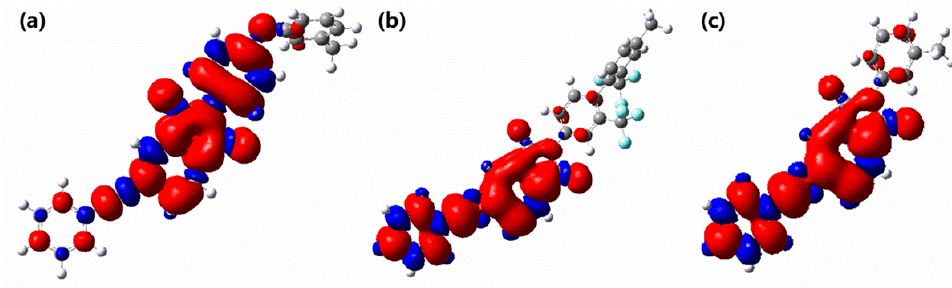
Figure 14. Energy minimized structures and natural bond orbital (NBO) charge of ethynyl group